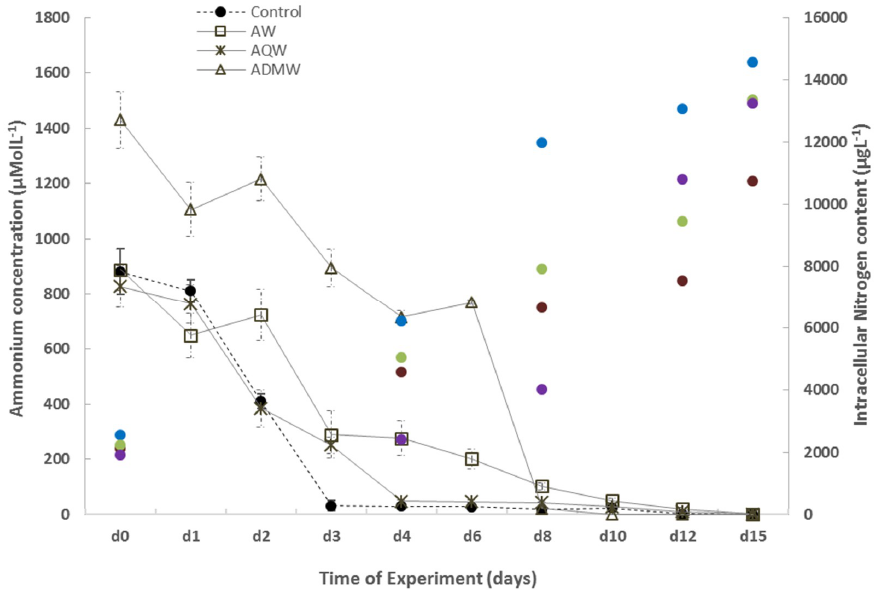
Figure 4. Ammonium uptake (in µ Mol L − 1 ); lines with markers) and intracellular nitrogen content of N. oceanica (in µ g L − 1 ; scatter) for Control medium F / 2; AW: Agricultural Waste; AQW: Aquaculture Waste; ADMW: Anaerobically Digested Municipal Waste. Error bars represent standard deviation for three biological replicates.